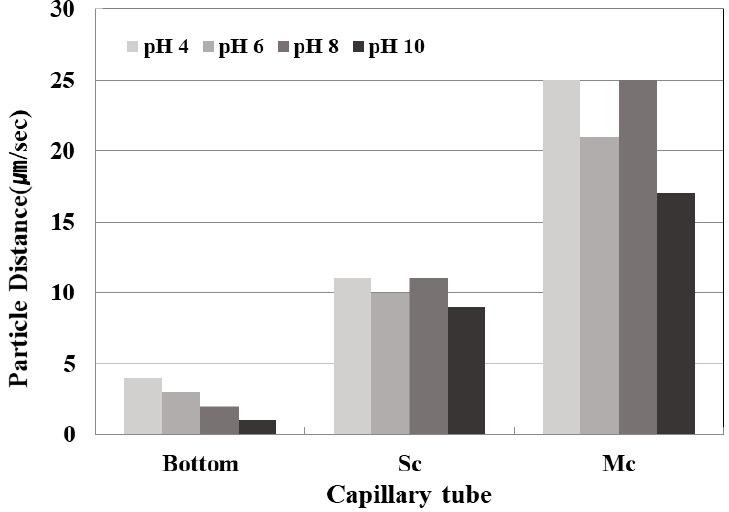
Figure 8. Micro particles distance ( μ m/s).